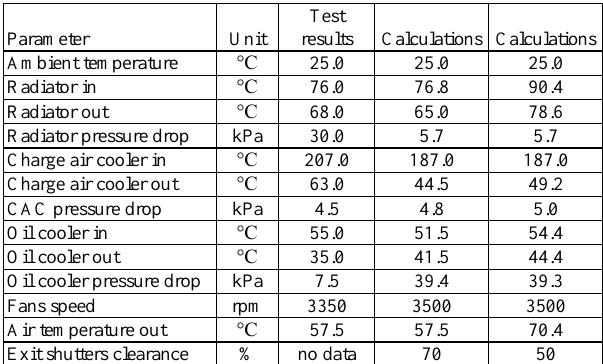
Table 2. Results of measurements and calculations for 25°C ambient